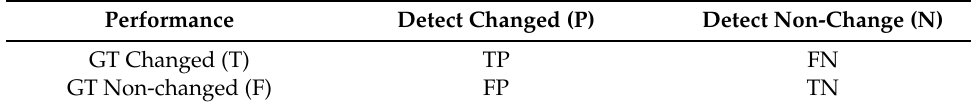
Table 1. Definition of quantitative